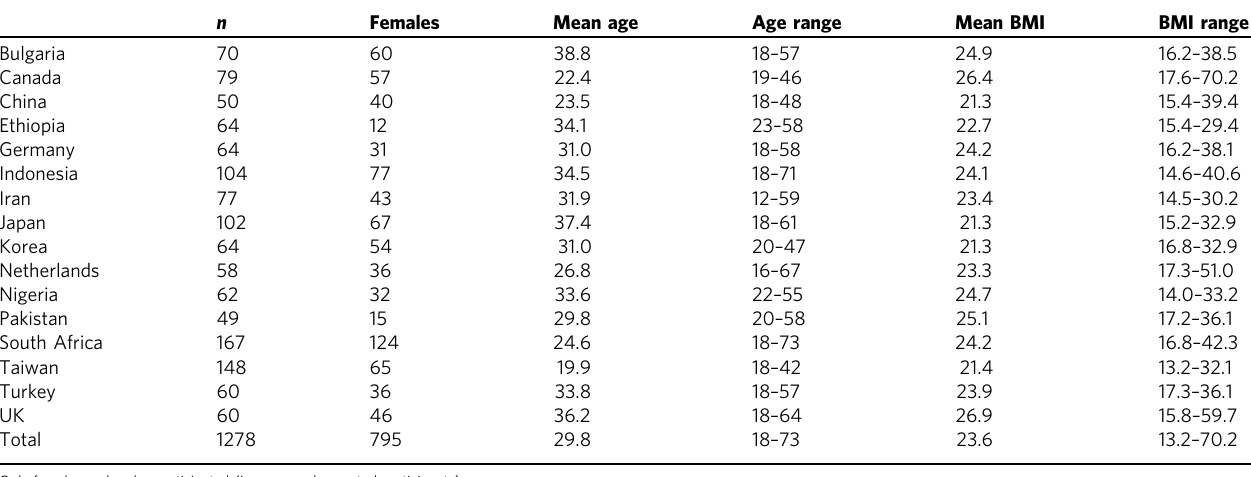
Table 1 Demographic information for each country.